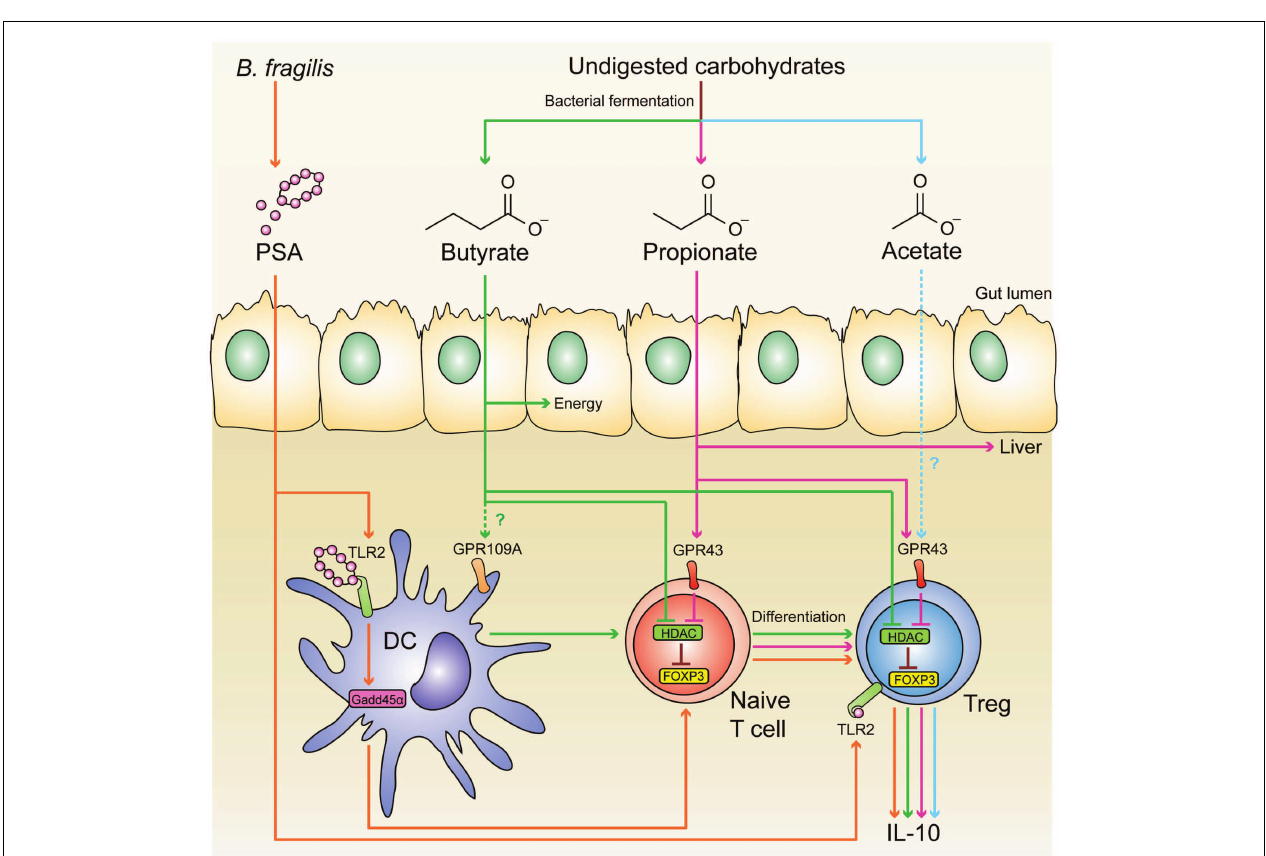
expression, thereby promotingTreg differentiation and IL-10 production, Butyrate has similar effects by either directly acting onTregs or through modulating DC function to enhance theirTreg-inducing ability; however, the role of GPR109A in these effects is controversial. Purified PSA derived from B. fragilis can also directly act onTregs throughTLR2 to promoteTreg function by enhancing expression of effector molecules including IL-10, TGF- β 2, and granzyme B. Membrane-bound PSA cannot act directly on Tregs, instead it interacts withTLR2 on DCs to promoteTreg differentiation in a Gadd45 α -dependent